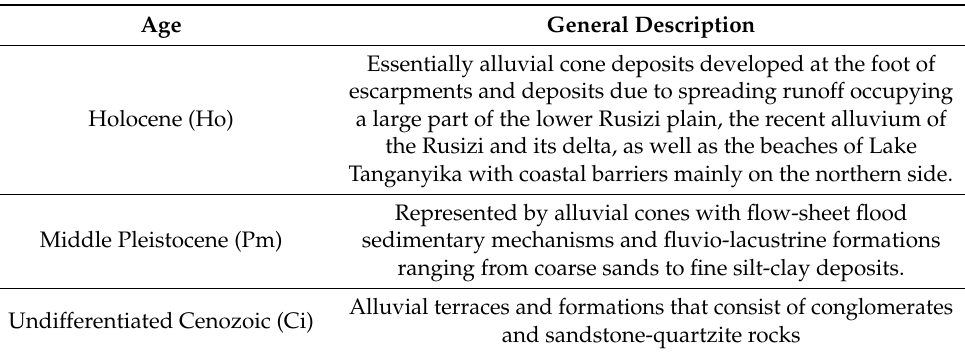
Table 1. Stratigraphic description of the lower Rusizi plain. Age General Description Essentially alluvial cone deposits developed at the foot of escarpments and deposits due to spreading runoff occupying Holocene (Ho) a large part of the lower Rusizi plain, the recent alluvium of the Rusizi and its delta, as well as the beaches of Lake Tanganyika with coastal barriers mainly on the northern side. Represented by alluvial cones with flow-sheet flood Middle Pleistocene (Pm) sedimentary mechanisms and fluvio-lacustrine formations ranging from coarse sands to fine silt-clay deposits. Alluvial terraces and formations that consist of conglomerates Undifferentiated Cenozoic (Ci) and sandstone-quartzite